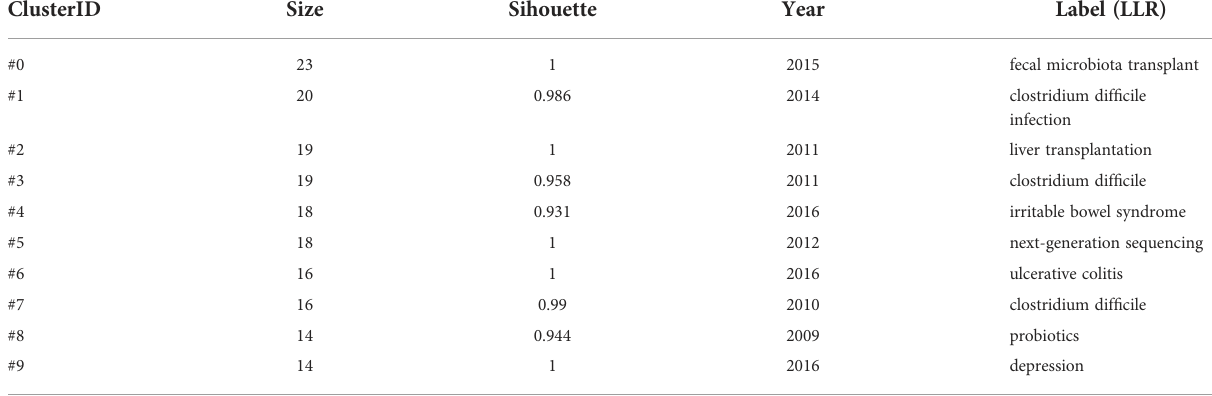
TABLE 8 Top 10 clusters of cited references related to FMT research. ClusterID Size